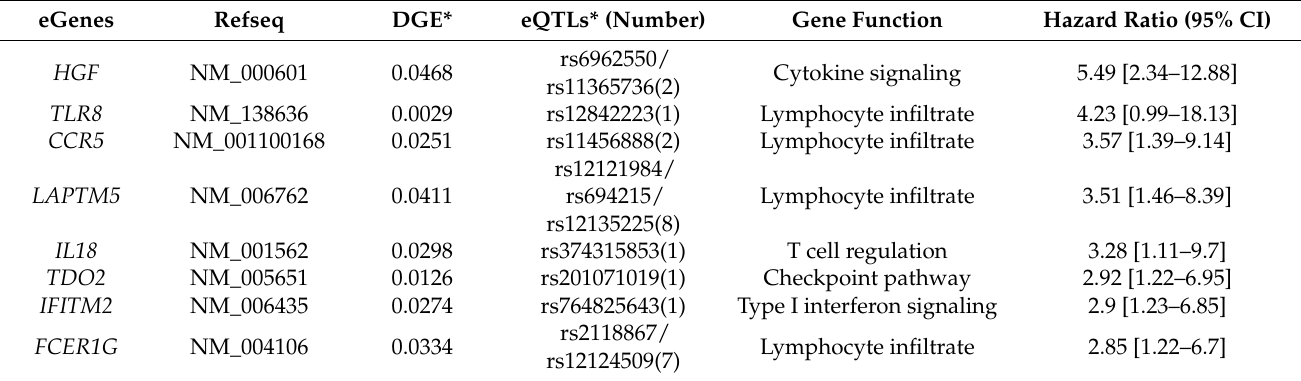
Table 1. Contributions of eVariants and eGenes to clinical